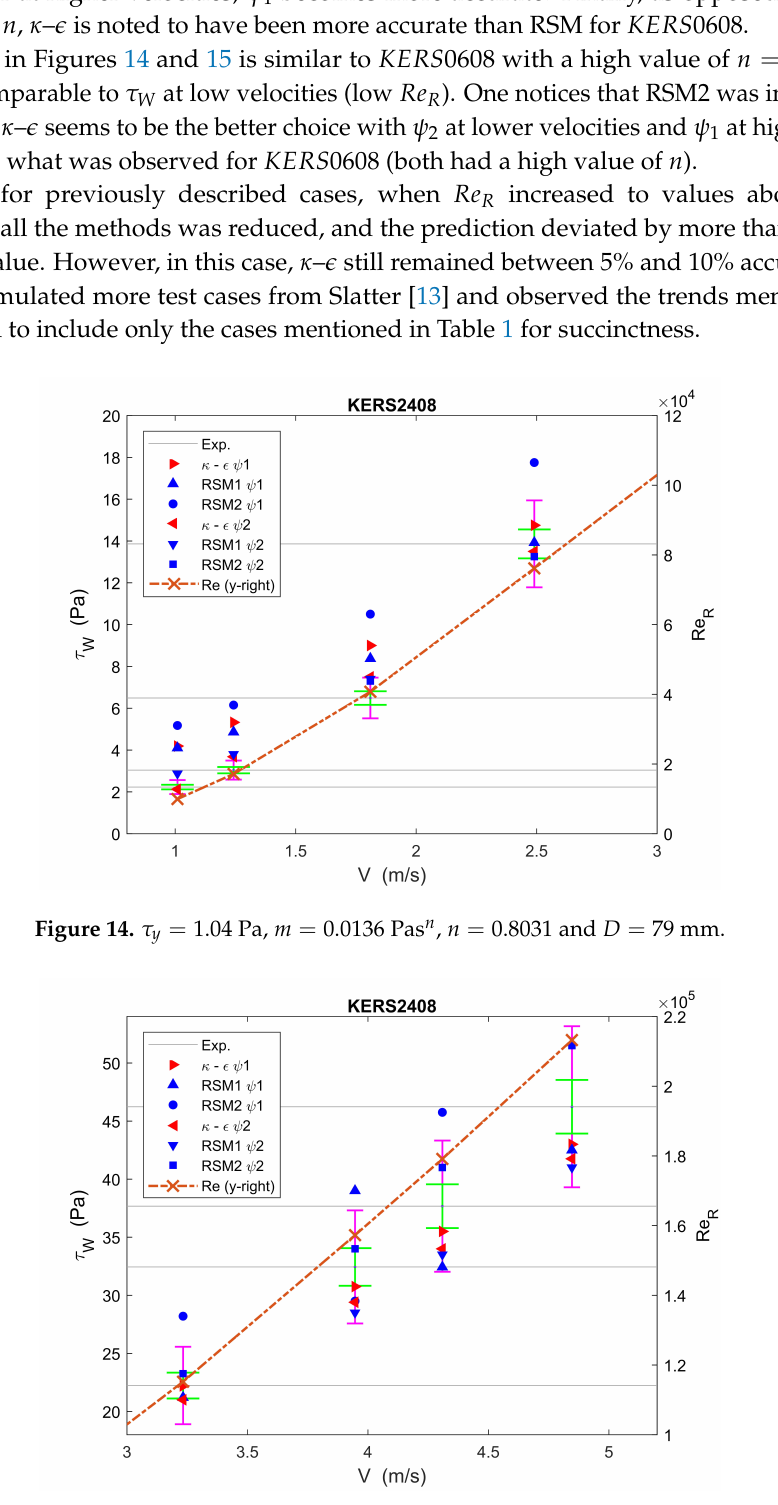
Figure 15. τ y = 1.04 Pa, m = 0.0136 Pas n , n = 0.8031 and D = 79